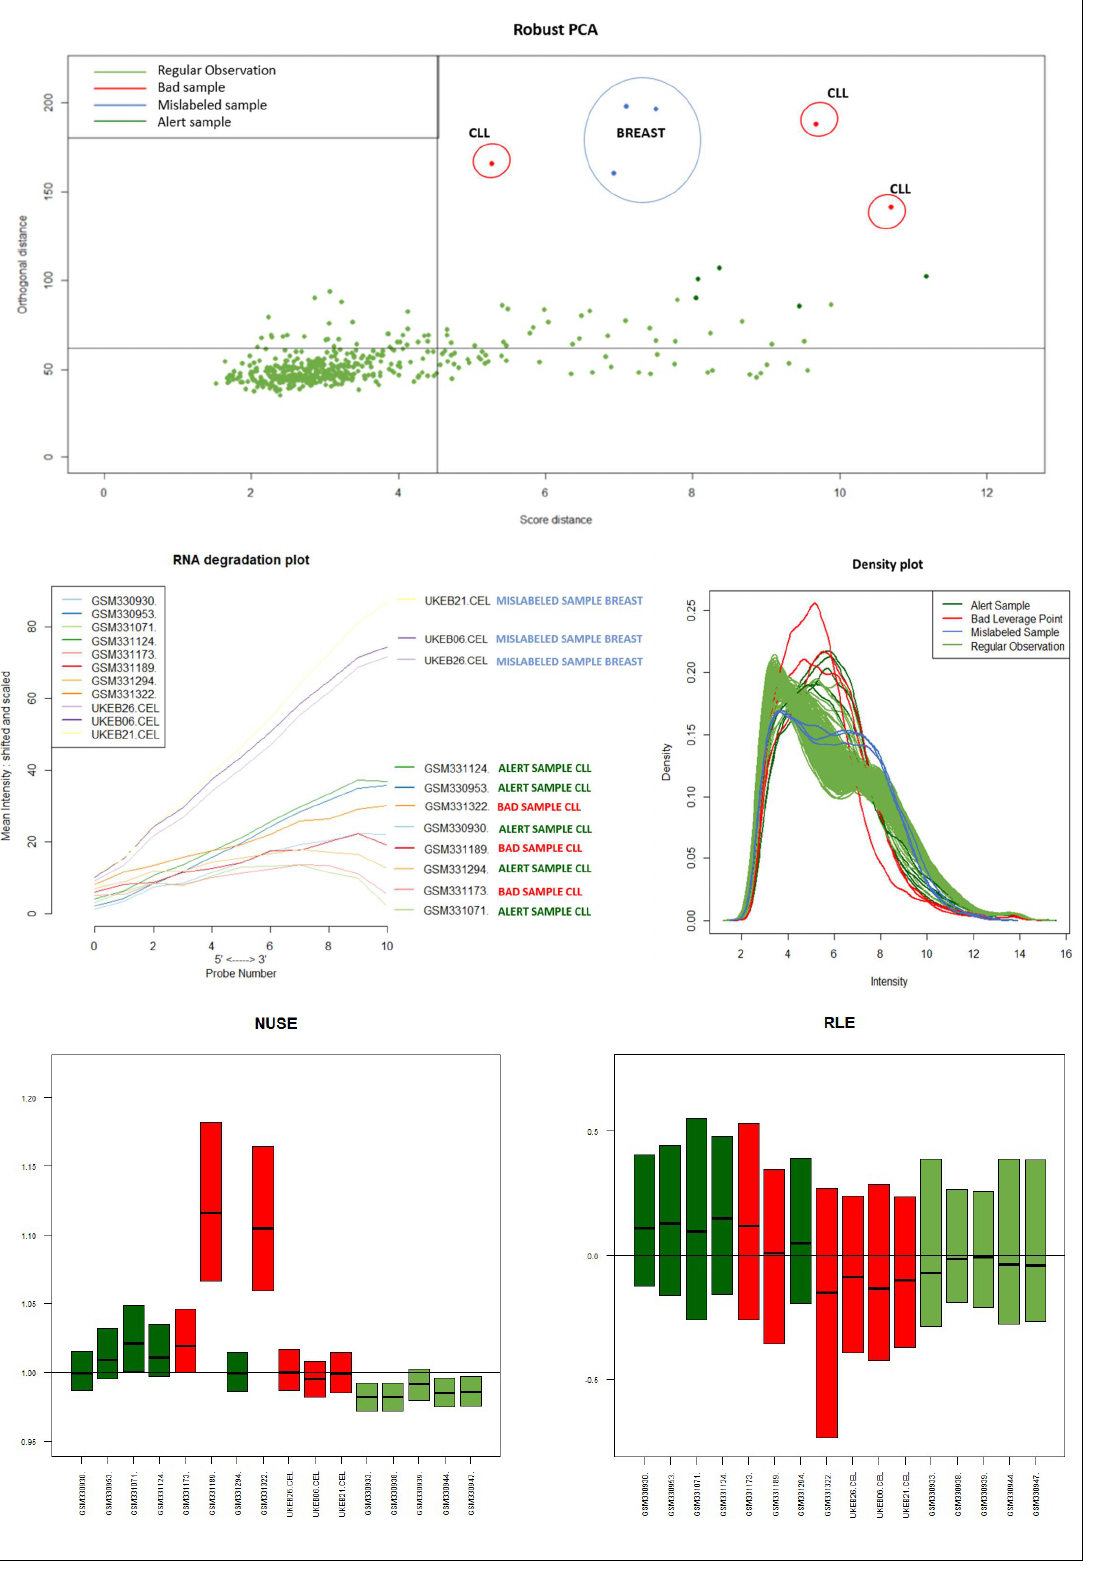
Figure A6. Summary of quality array measures for Dataset